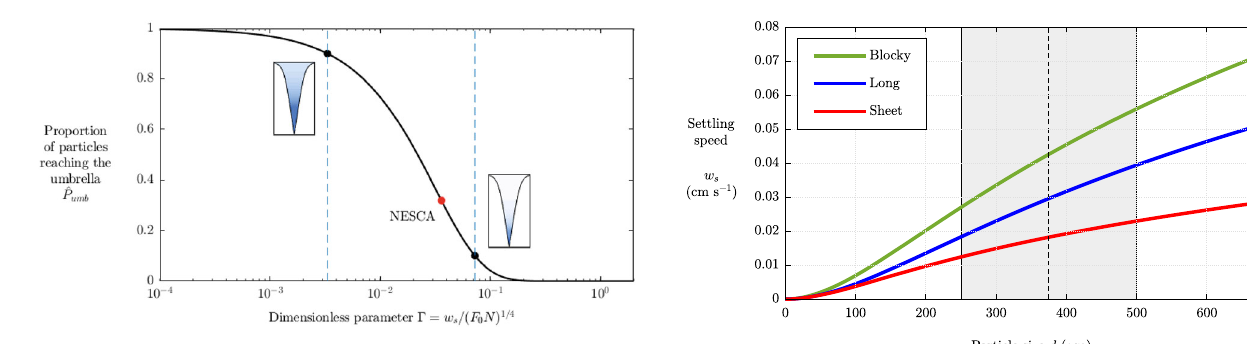
Fig. 6 Theoretical model for the proportion of particles reaching the umbrella of the eruptive plume. The prediction for the proportion of Fig. 7 Settling speed as a function of pyroclastic particle size. The settling particles reaching the umbrella given by Eq. (20) of the Methods as a speed w s of three different types of clast are plotted against the particle size = ð F function of the key dimensionless number Γ ¼ w N Þ 1 = 4 . The result d , as predicted by the formula of 48 with the coef fi cients for basaltic tephra s 0 shows that over 90% of particles reach the umbrella if Γ < 0.003 and under determined from tank experiments by 40 . The relationships are used to 10% reach the umbrella if Γ > 0.07. Insets illustrate the concentration fi eld determine the characteristic settling speeds of the particles in the of the plume c ð z Þ ¼ ^ P ð z Þ = ^ Q ð z Þ given by Eq. (21), with darker blue shading 250 – 500 μ m range, shown shaded, used to conduct our inversion for the representing a higher concentration. The red fi lled circle represents the volumetric fl ux of fl uid fed into the umbrella using Eq. value Γ ≈ 0.034 predicted for the Northern Escanaba (NESCA) eruption for the particle range 250 – 500 μ m using our inferred values of F 0 ≈ 600, w s = 3 cm s − 1 , for which ~32% of particles in this range are predicted to reach the umbrella.